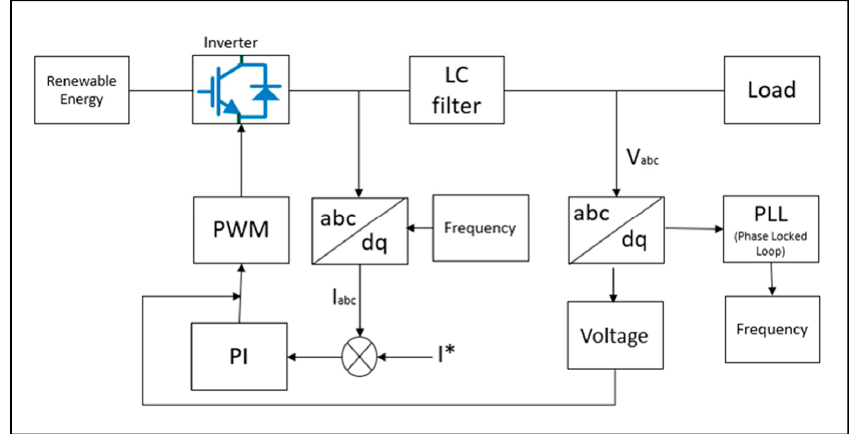
Figure 8. Example of V/f control strategy using I* (reference current) in AC bus.